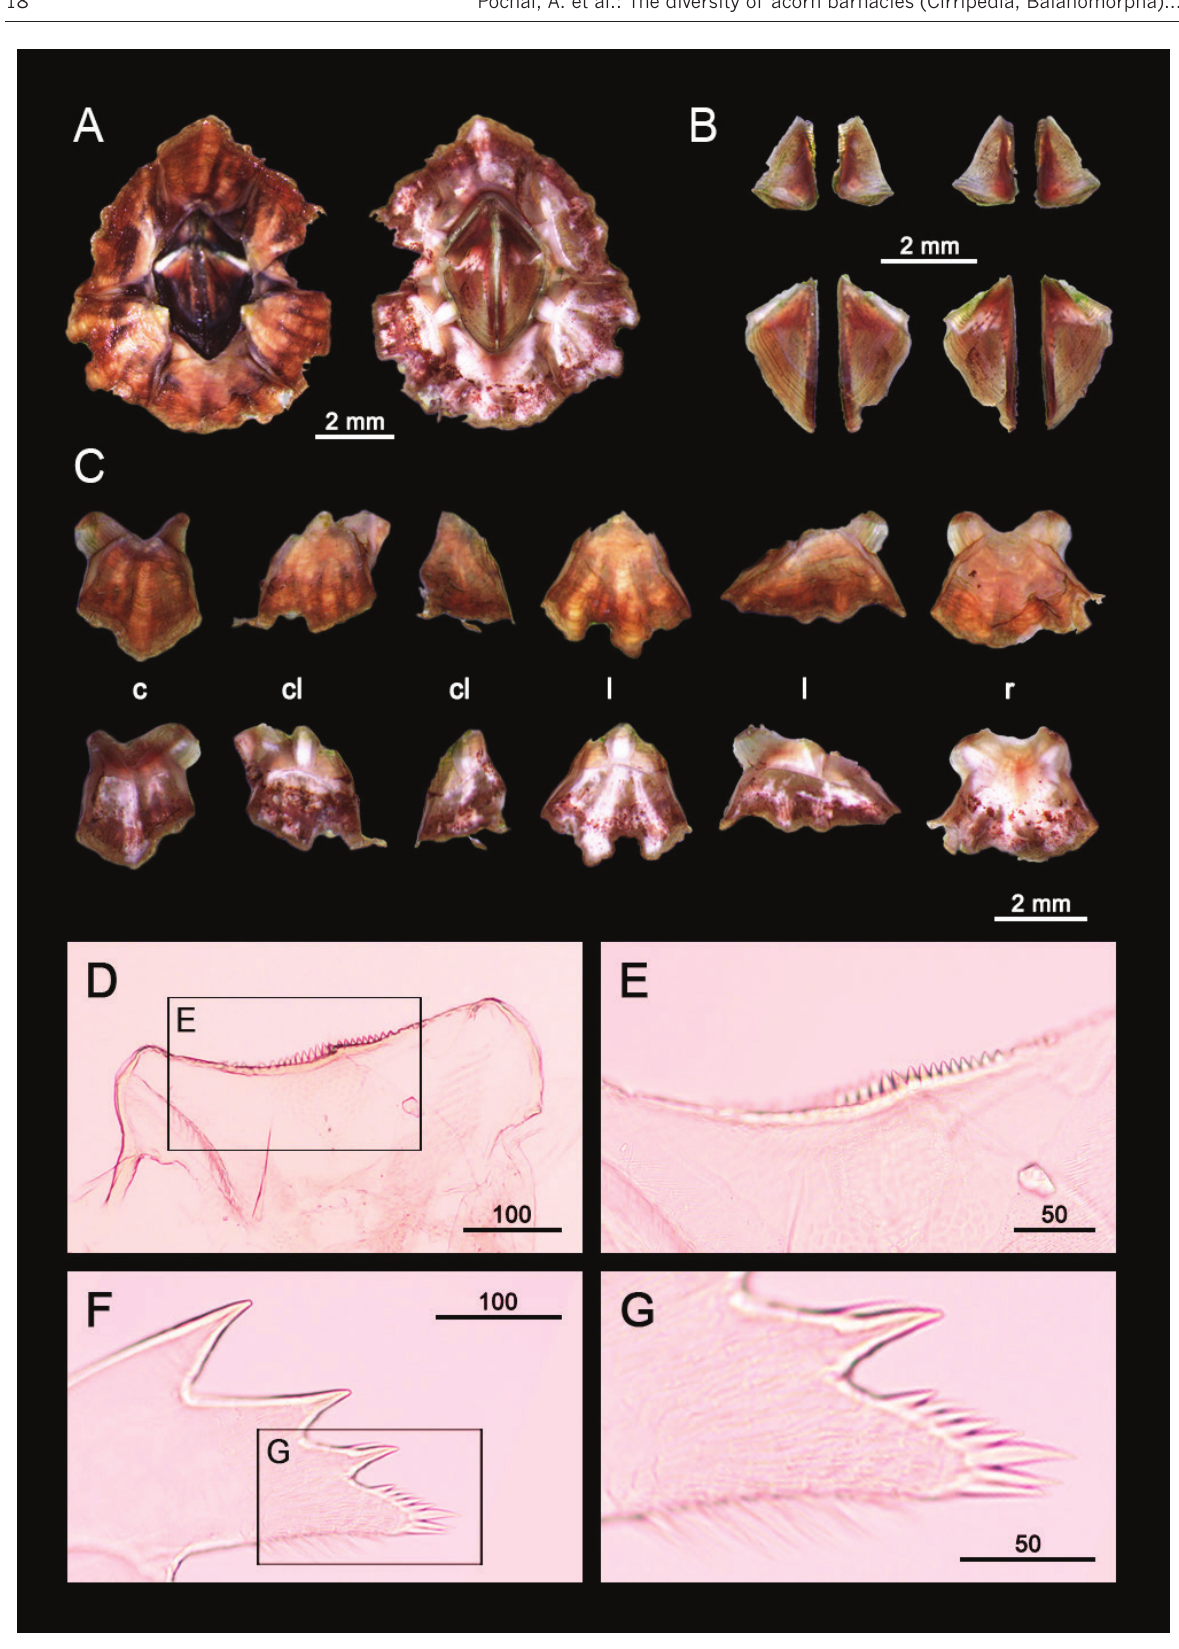
Figure 3. Euraphia depressa collected from Khao Sam Muk beach, Chon Buri (BUU16.CH.ED01). A. Dorsal and ventral view of external shell, B. External (left panel) and internal (right panel) view of tergum (upper panel) and scutum (lower panel), C. External (upper panel) and internal (lower panel) view of shell plates, D-G. Light microscopy on mouthparts, D. Labrum, E. Close up on the teeth of the labrum, F. Mandible with three large teeth, G. Close up on the pectinated lower margin of mandible. D–G. Scale bars in µm. Abbreviations: c, carina; cl, carinal latus; l, latus; r,